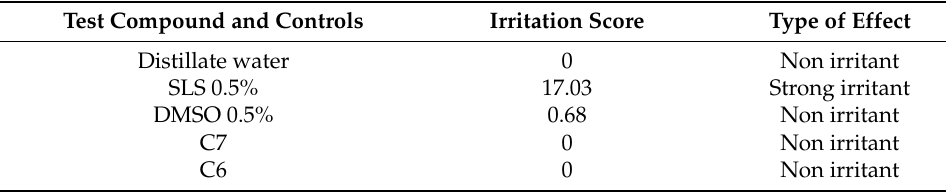
Figure 16. The irritation potential assessment using the HET-CAM method. Stereomicroscope images show the in face chorioallantoic membrane before (t0) and 300 s after application (t5) of 300 µ L of the test sample in concentration of 1 µ M and control samples (distilled water H 2 O as negative control, SLS 0.5% as positive control and DMSO 0.5% as solvent control); scale bars represent 500 µ m. Table 6. The irritant potential of